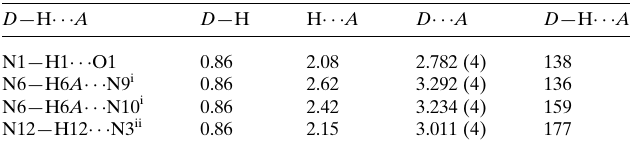
Table 1 Hydrogen-bond geometry (A˚ , (cid:3) ).